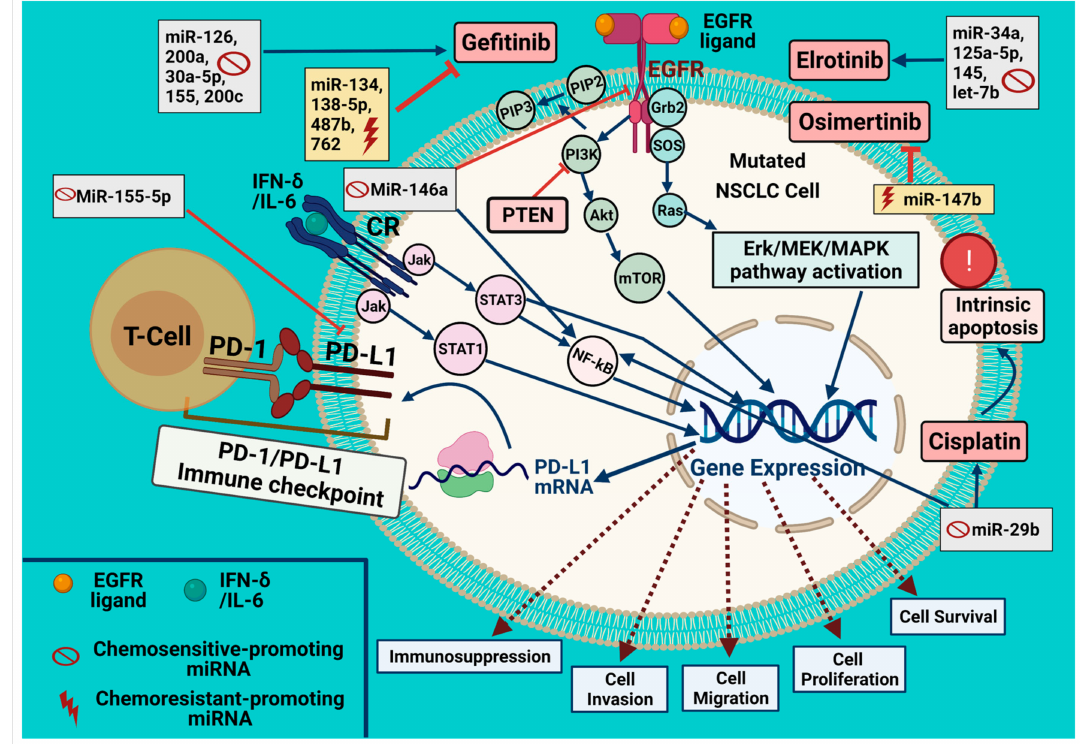
Figure 2. Role of miRNAs in modulating chemosensitivity to EGFR-TKIs and cisplatin in mutated NSCLC cells. In NSCLC tumor cells, EGFR activation results in activating Erk/MEK/MAPK, Akt/mTOR, and Jak/STAT signaling pathways. Cytokines (e.g., IFN-gamma and IL-6) bind to their respective cytokine receptors (CRs), leading to its activation. The